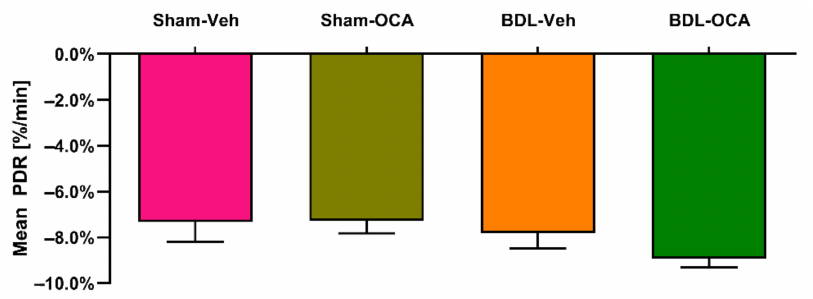
Figure 8. Indocyanine green (ICG) plasma disappearance rate (PDR) expressed as percentage per minute. Significance was assessed using a using a Kruskal–Wallis test with Dunn’s multiple comparisons test. Data points represent mean ± SEM. Veh, vehicle; OCA, obeticholic acid; BDL, bile duct